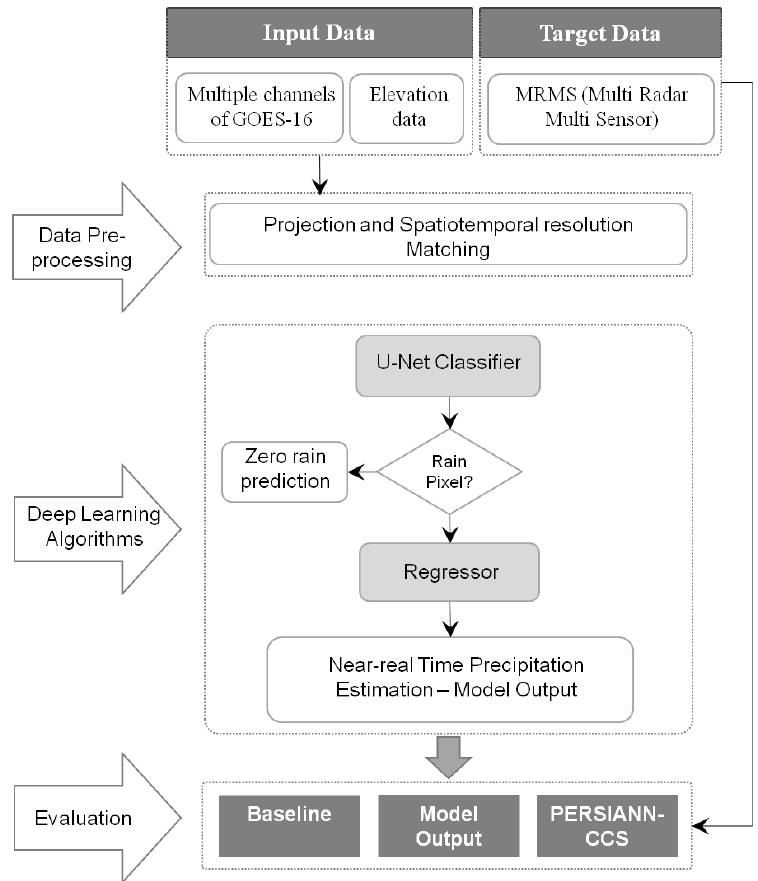
Figure 1. The proposed framework for the Precipitation